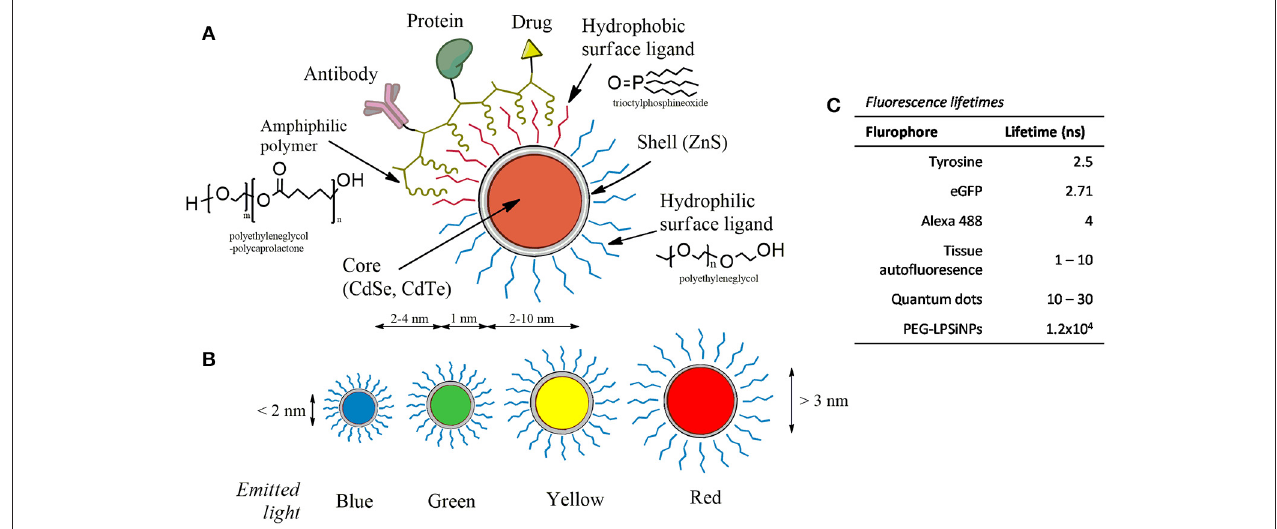
FIGURE 2 | The anatomy of quantum dots. (A) QDs contain a semiconducting core-shell. The surface can be coated with hydrophilic, hydrophobic, and amphiphilic ligands (common coating molecules are shown) which can be further linked with proteins, drugs, antibodies, and other compounds. (B) The emission spectra of QDs can be tuned by adjusting the size. (C) Fluorescence lifetimes of QD in comparison with other flurophores (Berezin and Achilefu, 2010; Gu et al., 2013).